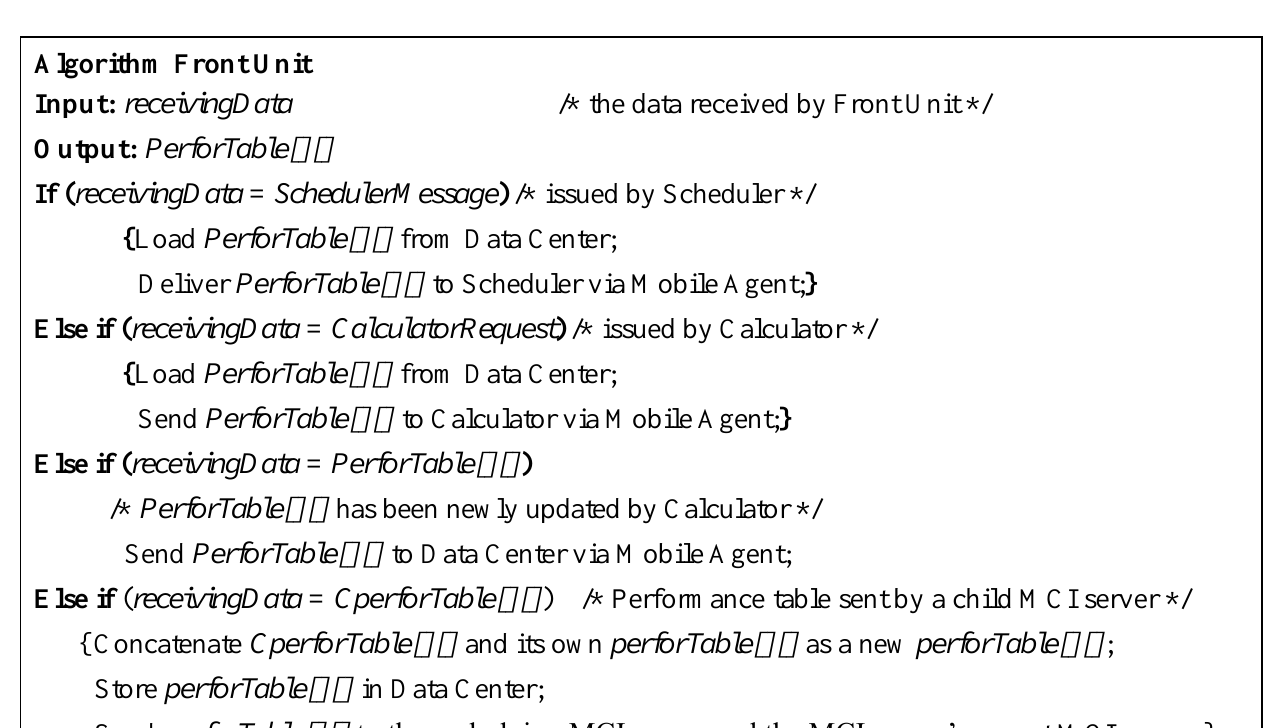
Figure 5. The algorithm performed by Front